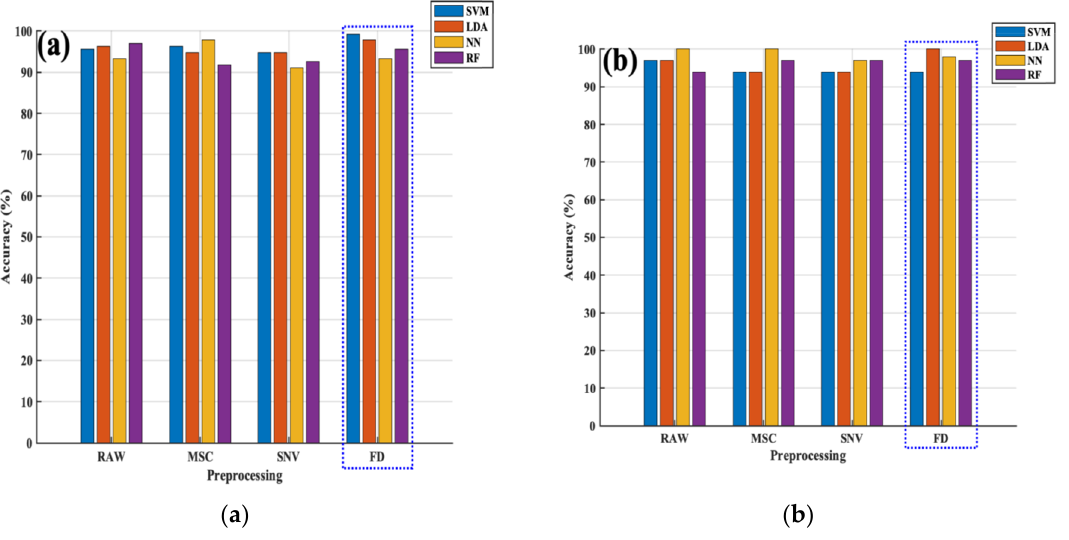
Figure 5. Accuracy in ( a ) calibration set and ( b ) prediction set for SVM, LDA, NN and RF models of Coffee samples. Table 2. Optimum discrimination accuracy for the models developed.